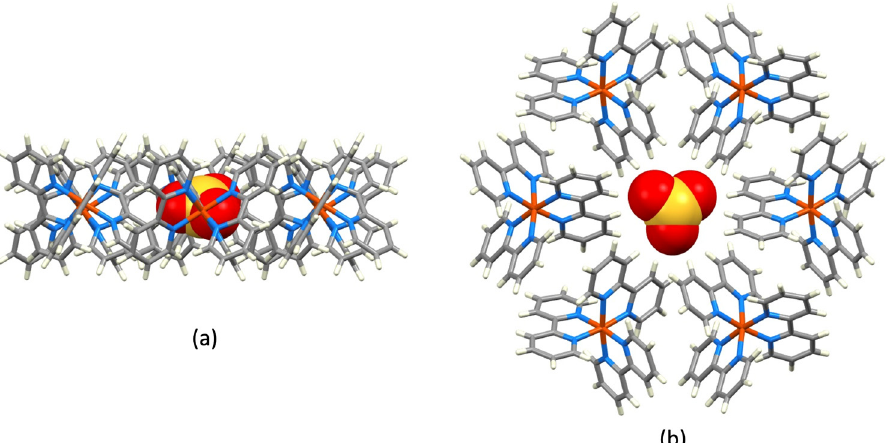
Figure 3. Structure Type I illustrated with the motif found in [Fe(bpy) 3 ] 2 [SO 3 ][OH] 4 . 14H 2 O which possesses a sheet structure (refcode YAWWAY) [46]. ( a ) One hexagonal motif within one sheet viewed down the crystallographic a -axis, and ( b ) the same unit viewed from above showing the twelve bpy H3 and H3 ′ atoms oriented towards the [SO 3 ] 2– ion.